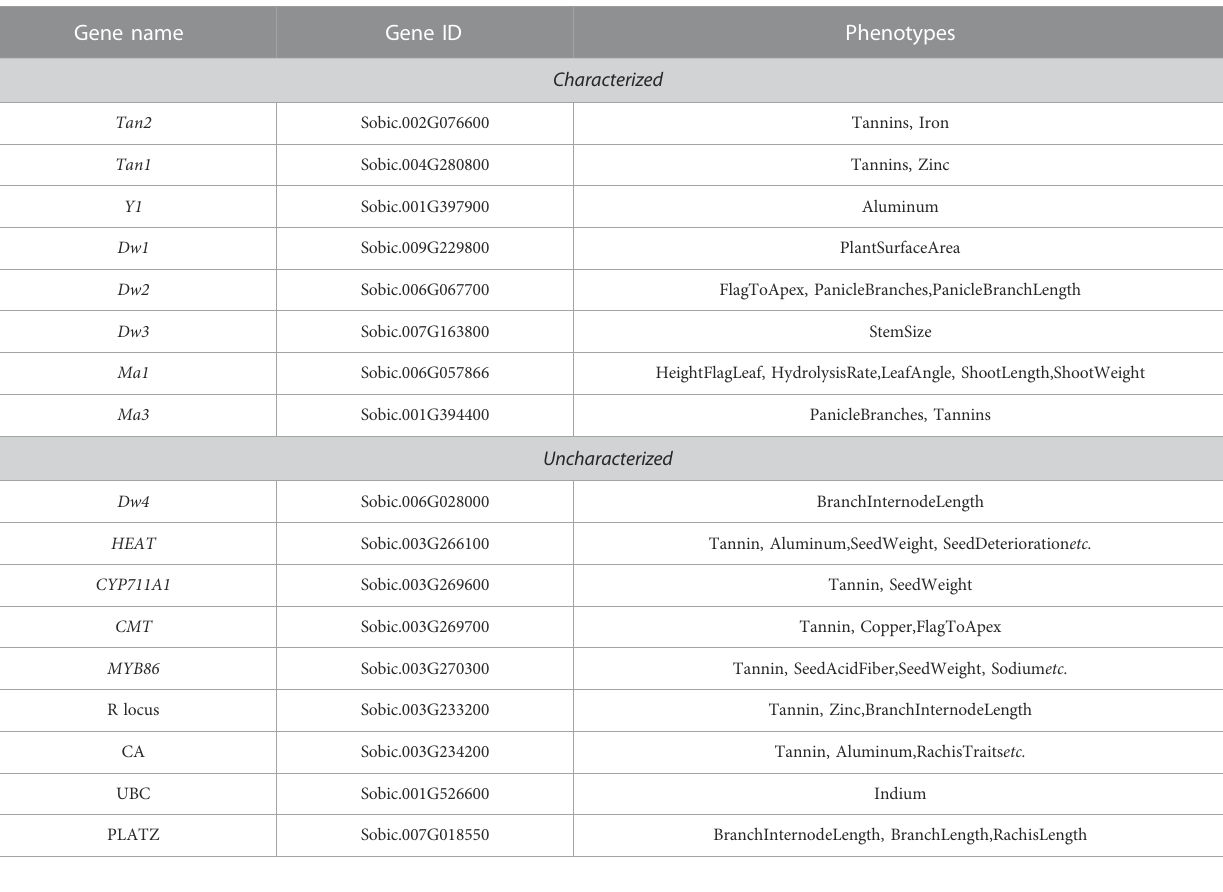
TABLE 1 Genotype-Phenotype associations by gene.